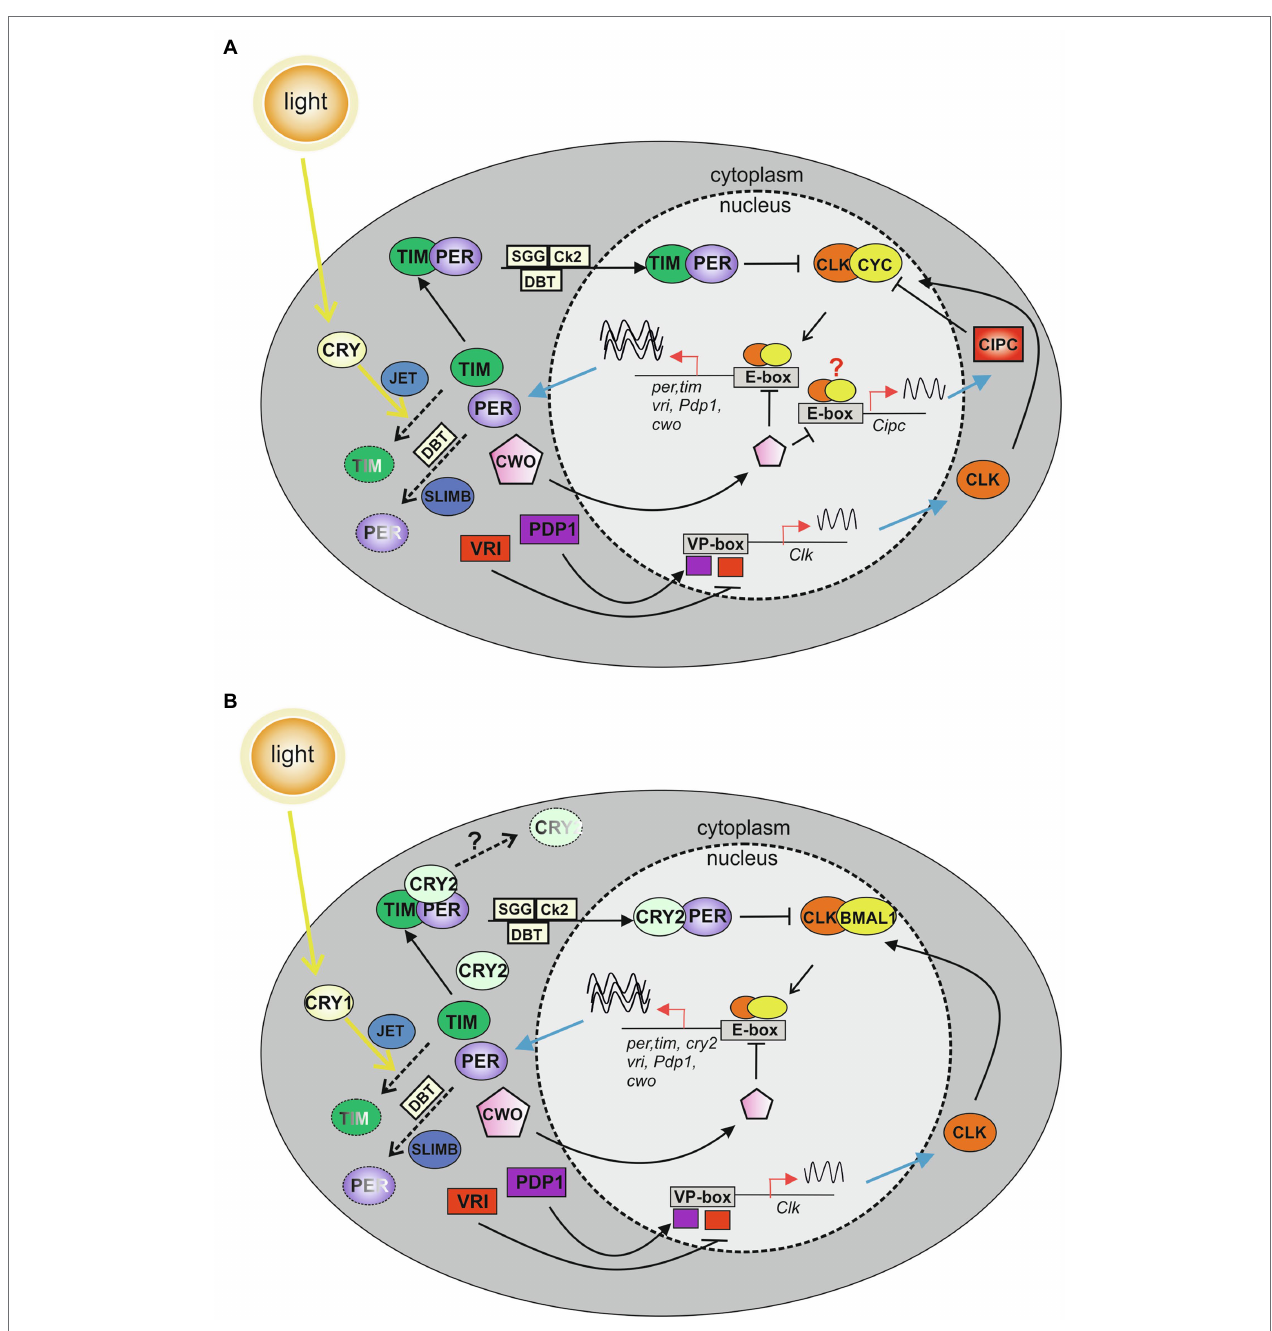
FIGURE 2 | Model of the major transcription–translation feedback loops (TTLs) in the circadian molecular clock of Drosophila melanogaster (A) and Lepidoptera (B) . (A) In the first TTL of D. melanogaster , CLOCK (CLK) and CYCLE (CYC) dimerize and bind to E-boxes in the promoters of per and tim clock genes. PERIOD (PER) and TIMELESS (TIM) enter the nucleus as a complex, and inhibit CLK-CYC activity (Allada et al., 1998; Bae et al., 1998; Darlington et al., 1998; Rutila et al., 1998; Glossop et al., 1999; Lee et al., 1999). A second TTL modulates Clk expression: CLK:CYC dimers induce the transcription of vrille ( vri ) and par domain protein 1 ( Pdp1 ) genes. VRI and PDP1 compete for the same element (VP-box) in the Clk promoter, controlling Clk transcription (Cyran et al., 2003). In the third TTL, CLK:CYC dimers activate the transcription of clockwork orange ( cwo ). CWO enters the nucleus and inhibits CLK:CYC activity by binding to E-box elements of clock genes (Kadener et al., 2007; Lim et al., 2007; Richier et al., 2008). CWO acts also indirectly promoting CLK:CYC-mediated transcription, by repressing the production of the CLK:CYC inhibitor CLOCK INTERACTING PROTEIN CIRCADIAN (CIPC; Rivas et al., 2021). Cipc transcription modulation might occur at the level of the E-boxes detected in the Cipc locus (red question mark; Rivas et al., 2021). Phosphorylation mediated by DOUBLETIME (DBT), CASEIN KINASE 2 (CK2), and SHAGGY (SGG) modulate clock protein activities, regulating protein–protein interactions, nuclear translocation, and degradation (Curtin et al., 1995; Saez and Young, 1996; Price et al., 1998; Rothenfluh et al., 2000; Martinek et al., 2001). Light activates the photoreceptor CRYPTOCHROME (CRY), which interacts with TIM